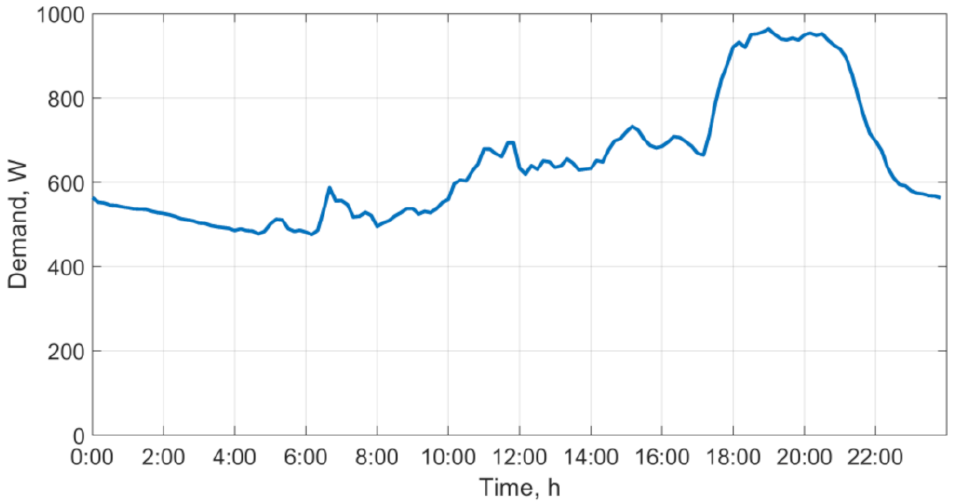
Figure 17. Total daily demand profile of households in the Gilutongan Island solar microgrid averaged over the months of October and November 2020.